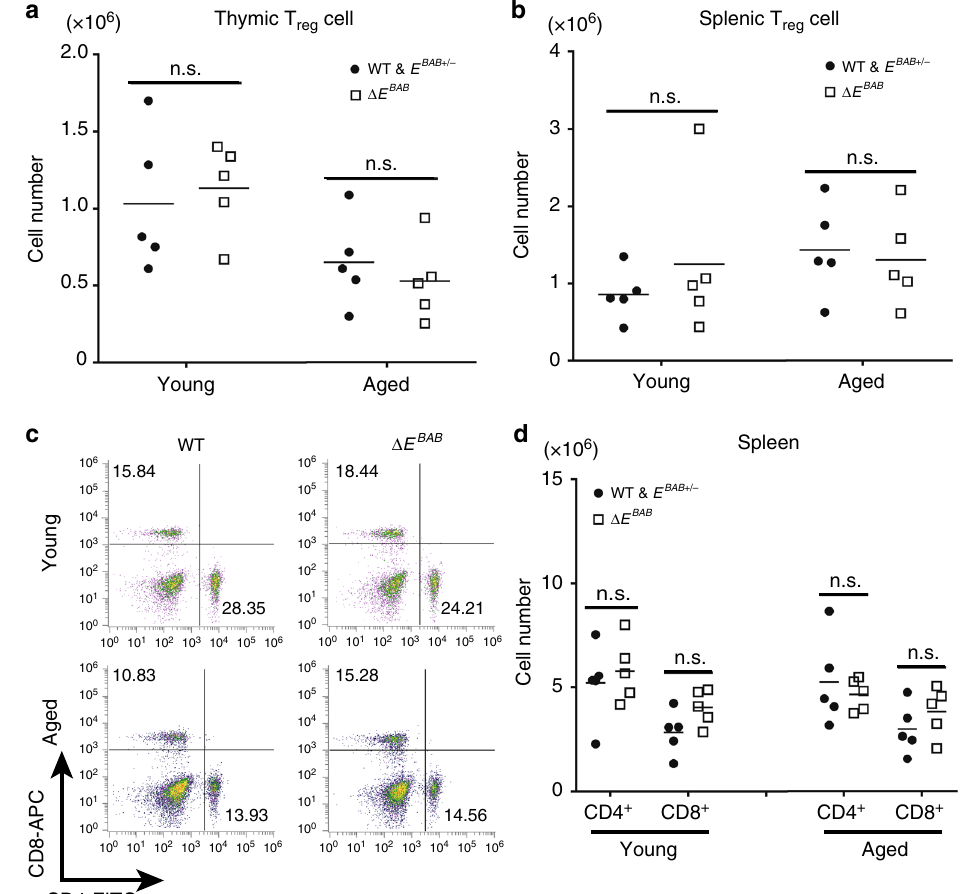
Fig. 6 E BAB does not play a major role in maintaining homeostasis of regulatory T cells and peripheral T cells. a , b CD4 + Foxp3 + thymic ( a ) and splenic ( b ) T reg cell numbers of young and aged mice. Data are pooled from fi ve independent experiments (Young; n = 5 WT and E BAB + / − – Δ E BAB littermate pairs, 9 – 12 weeks old, Aged; n = 5 WT E BAB + / − – Δ E BAB littermate pairs, 30 – 36 weeks old). c Flow cytometric analysis of CD4 versus CD8 T cell populations in the spleen. The number in the plot is representative percentage of each gate. Data are representative of fi ve independent experiments (Young; n = 5 WT and E BAB + / − – Δ E BAB littermate pairs, 7 – 17 weeks old, Aged; n = 5 WT and E BAB + / − – Δ E BAB littermate pairs, 30 – 36 weeks old). d CD4 + and CD8 + splenic T cell numbers. Data are pooled from fi ve independent experiments (Young; n = 5 WT and E BAB + / − – Δ E BAB littermate pairs, 7 – 17 weeks old, Aged; n = 5 WT and E BAB + / − – Δ E BAB littermate pairs, 30 – 36 weeks old). Each symbol in ( a , b , d ) represents an individual mouse; small horizontal lines indicate the mean. n.s. not signi fi cant ( P ≥ 0.05) (unpaired two-tailed Student ’ s t